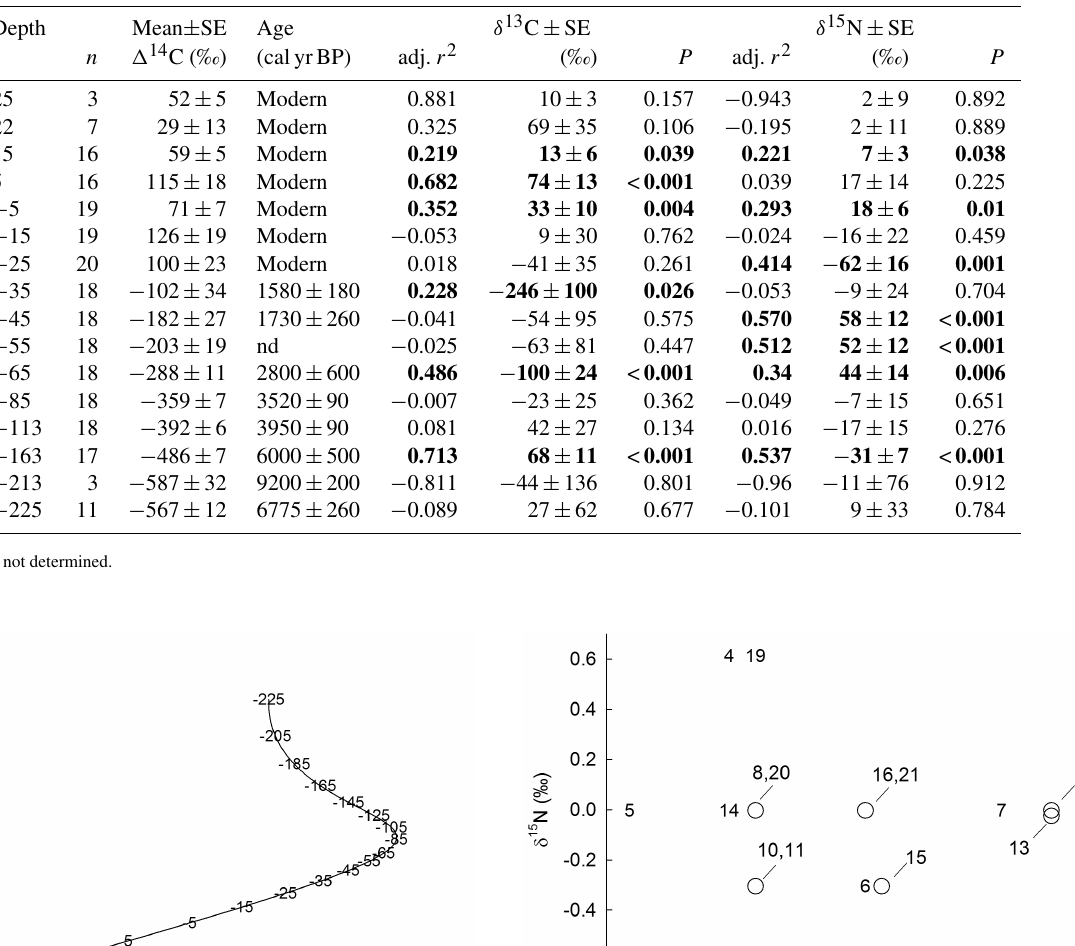
Table 4. Correlations between radiocarbon and stable isotopes by depth, and mean (cid:49) 14 C for that depth. Hummock vs. hollow plots and treed vs. non-treed plots were averaged together. δ 13 C ± SE and δ 15 N ± SE columns reflect the shift in (cid:49) 14 C with a 1‰ shift in δ 13 C or δ 15 N. Statistically significant correlations are bolded.